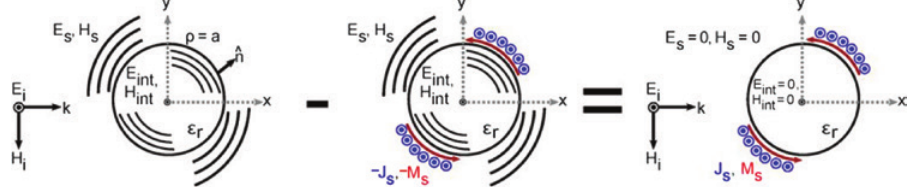
Figure 23: Schematic explanation for the active Huygens cloak. Left: scattering of a plane wave off a cylindrical dielectric piece. Middle: scattering off the same object, with the incident plane wave replaced by an equivalent set of electric and magnetic currents surrounding the object. The scattered waves were the same for the left and middle scenarios. Right: the destructive interference of scattered waves was facilitated by implementing a cloak with the negative of the aforementioned equivalent currents. Obtained from Ref. [27].